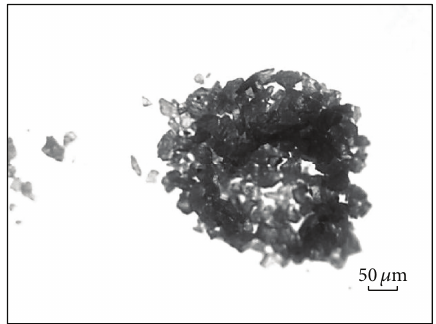
Figure 7: Hydrophobic aggregation photo of sphalerite (treated with ACS and SIBX).